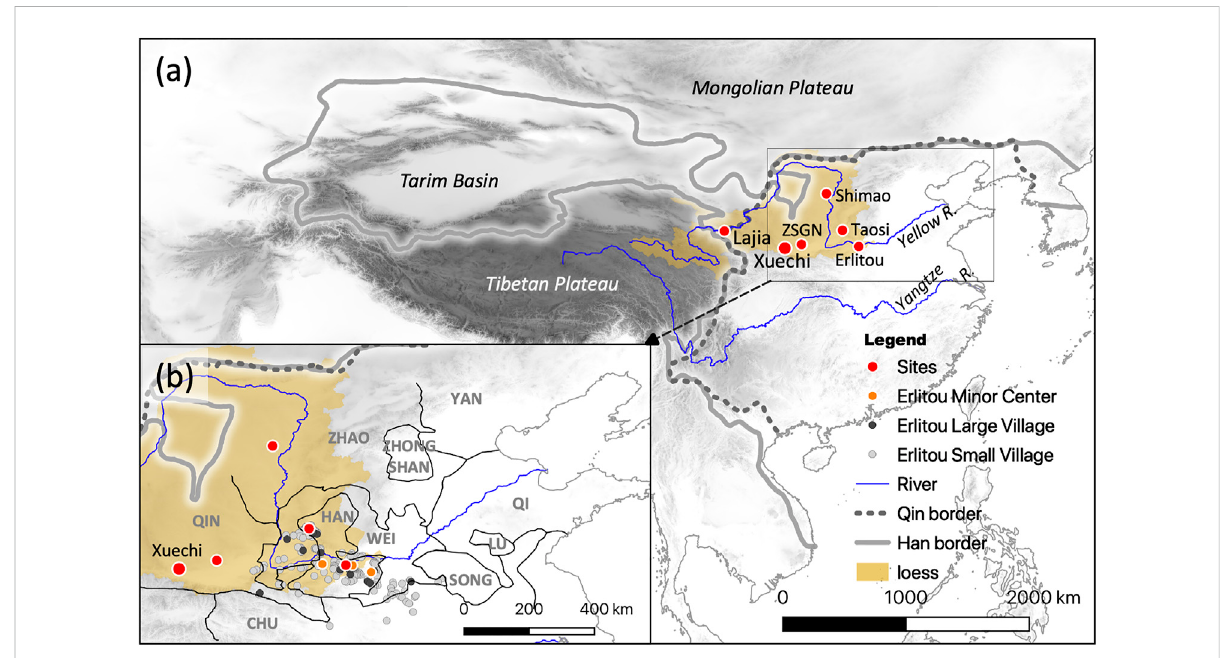
Historical contexts of the early Chinese states. (A) The comparable sites mentioned in the text and the boundary of Qin-Han Empires (ca. 210 BCE); (B) the distribution of Erlitou sites overlapped on the territorial borders of main kingdoms during the Warring States periods (ca. 350 BCE). The borders were redrawn after The Historical Atlas of